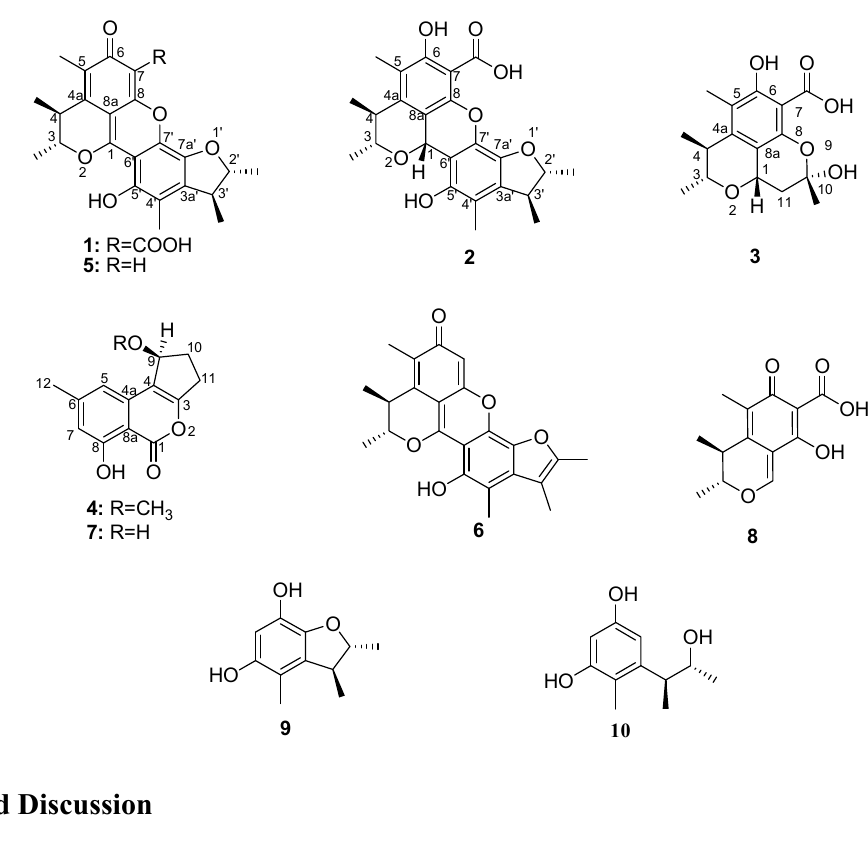
Figure 1. Structures of the isolated compounds 1 – 10